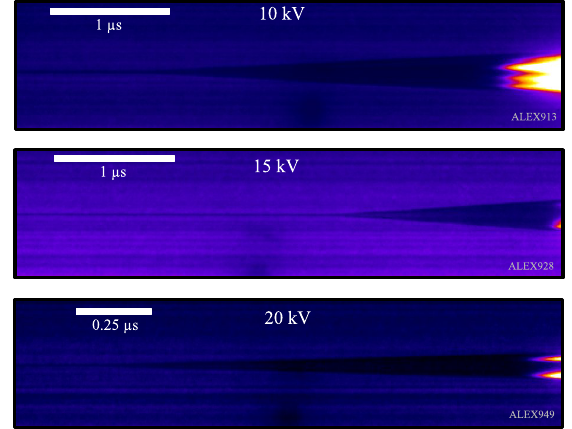
Figure 4. Typical streak images of platinum metal gas expansion with different charging voltages. Space scale is the same than in previous cases, Figure 3, but notice the timescale of the last experiment. As in previous figure, line at the left is the wire before the electrical